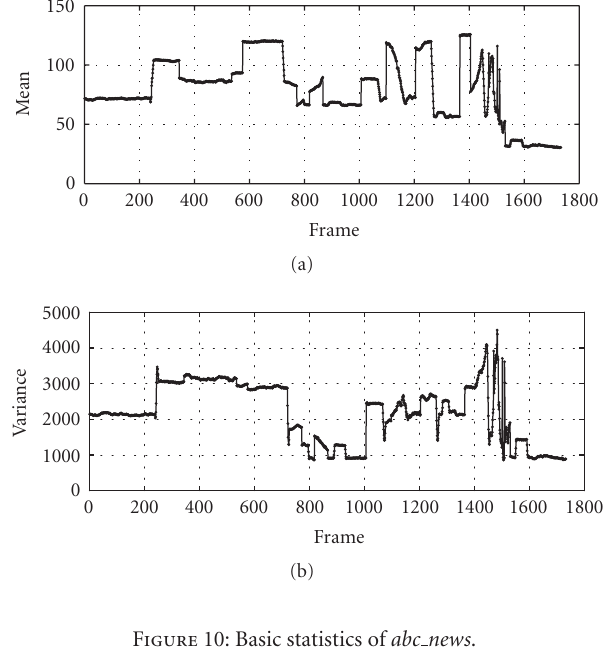
Figure 10: Basic statistics of abc news .